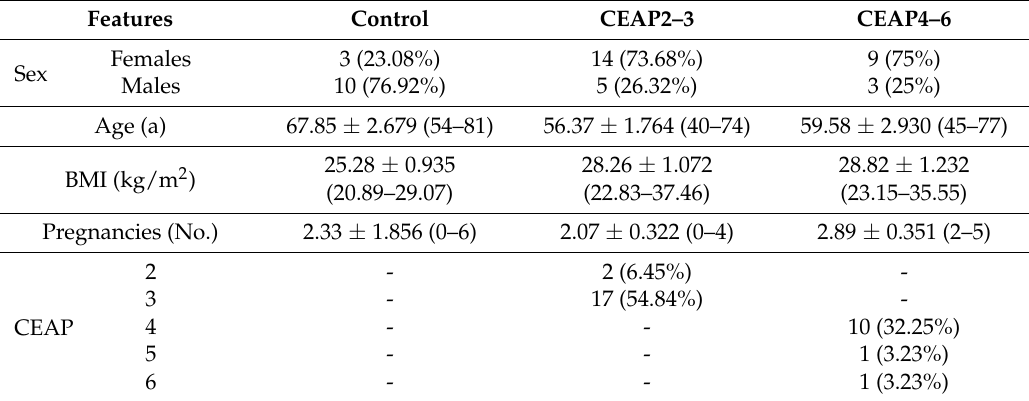
Table 1. Participants’ demographic and clinical features. Data shown in this table refer to the total number of participants from which subgroups were selected (in order to achieve demographic and clinical feature equivalence) for further analyses.